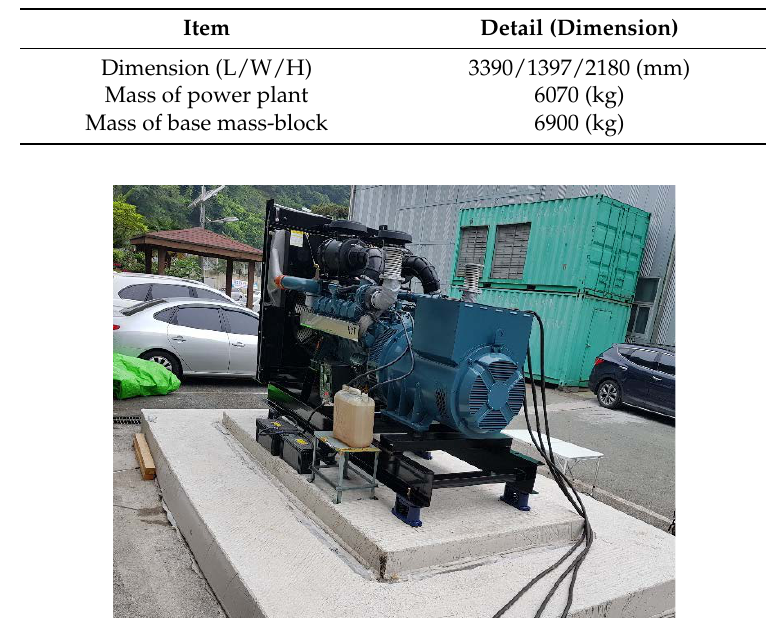
Figure 1. Electric power plant with 750 KW capacity.